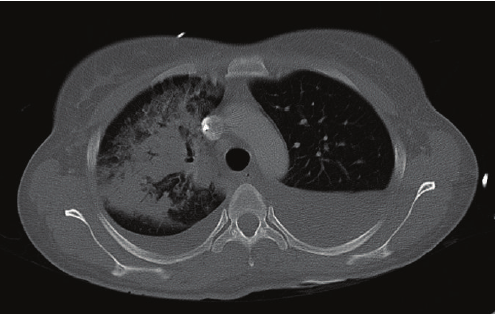
Figure 3: CT-scan showing de novo consolidation of the right lung, 24 hours after surgery.